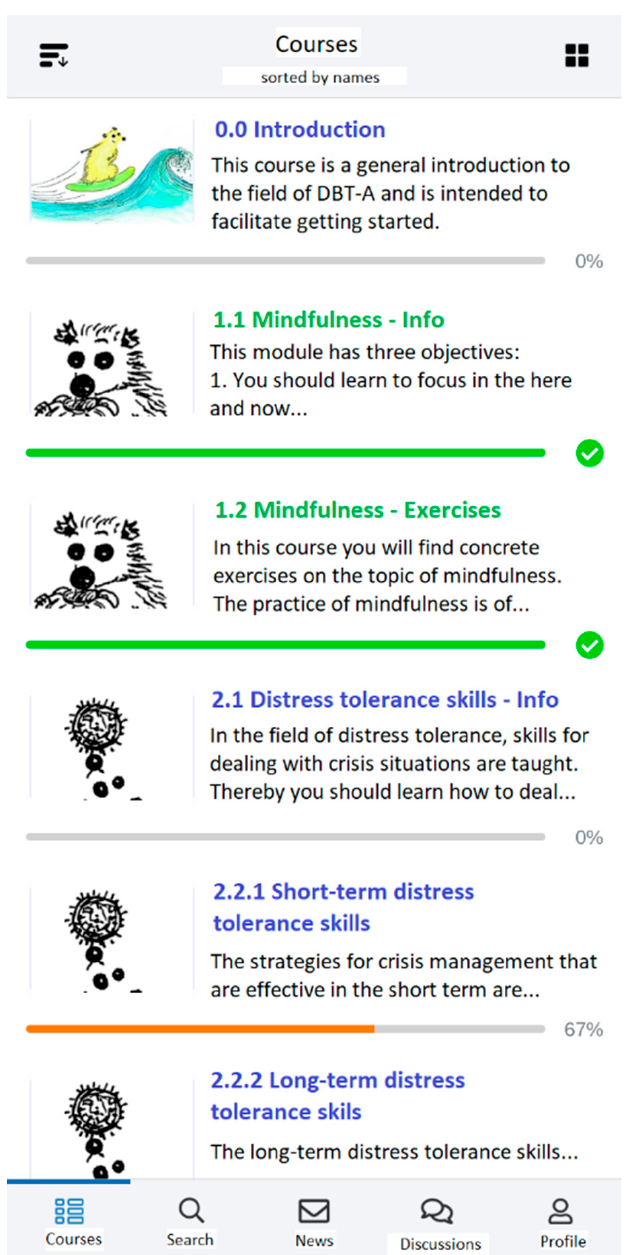
Figure A1. Overview of courses.